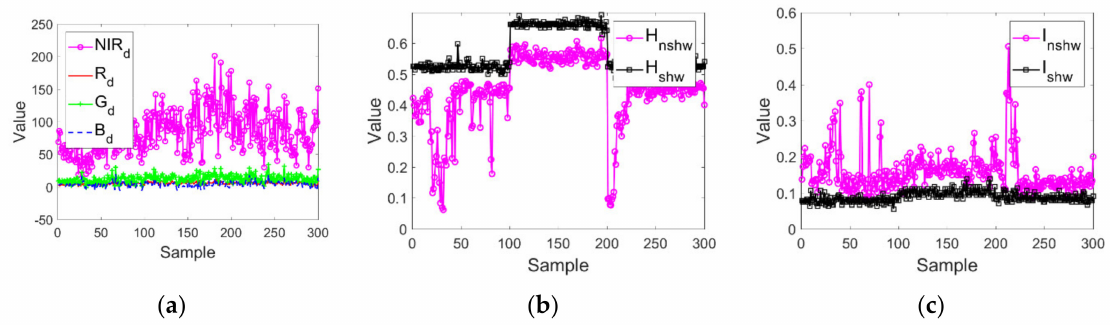
Figure 2. Dramatic decrease in terms of near-infrared ( NIR ) component, higher hue ( H ) component value and lower intensity ( I ) component value in shadow regions with samples for typical objects (taking the WorldView-3 as an example). ( a ) NIR . ( b ) H . ( c ) I